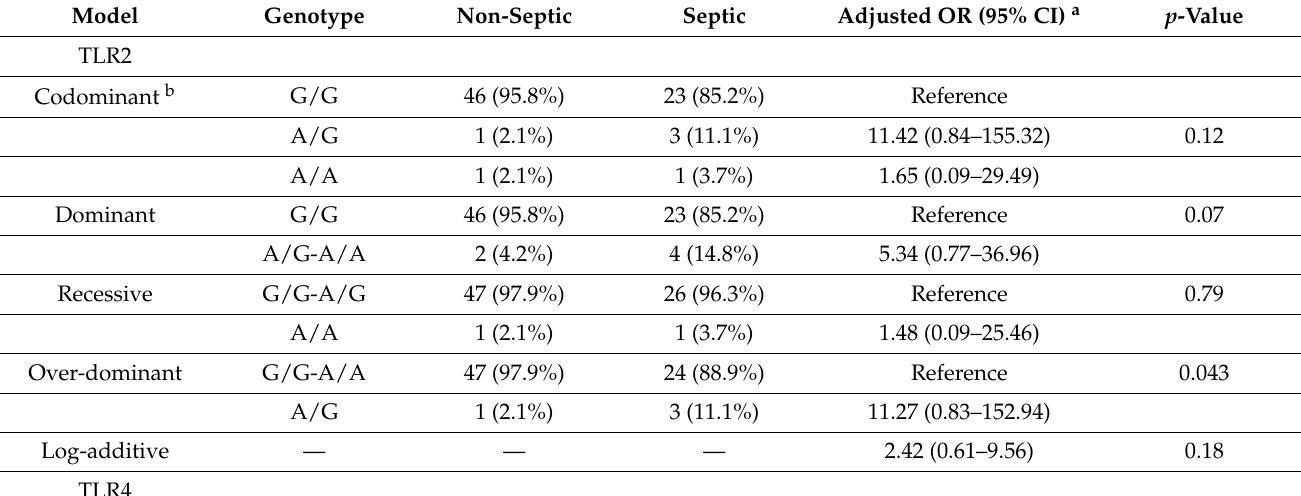
Table 4. Genotype association models for sepsis risk